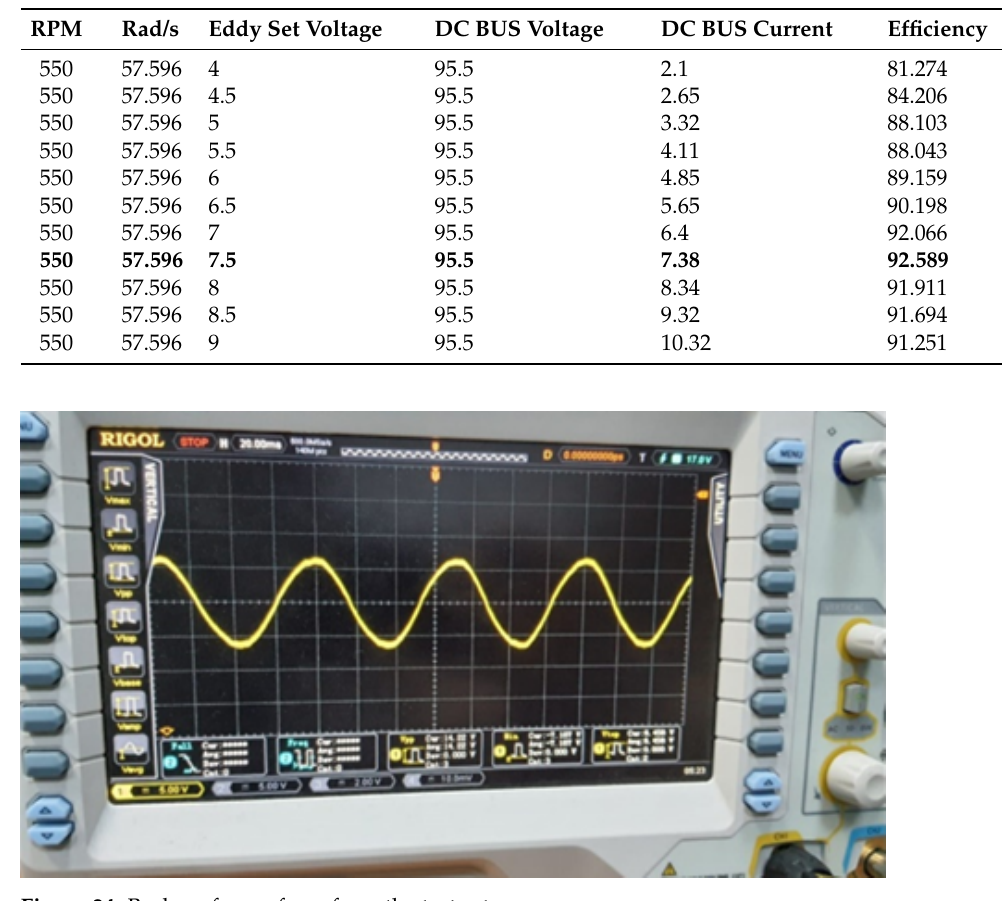
Table 2. Efficiency measurement under constant speed and varying torque on the motor’s test.